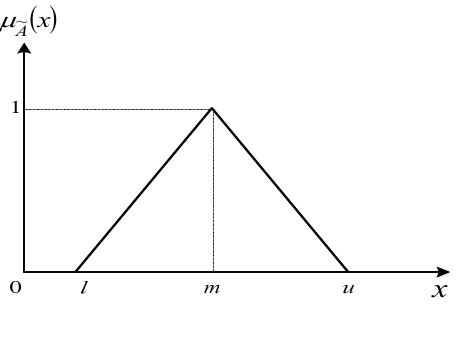
Figure 1. A triangular fuzzy